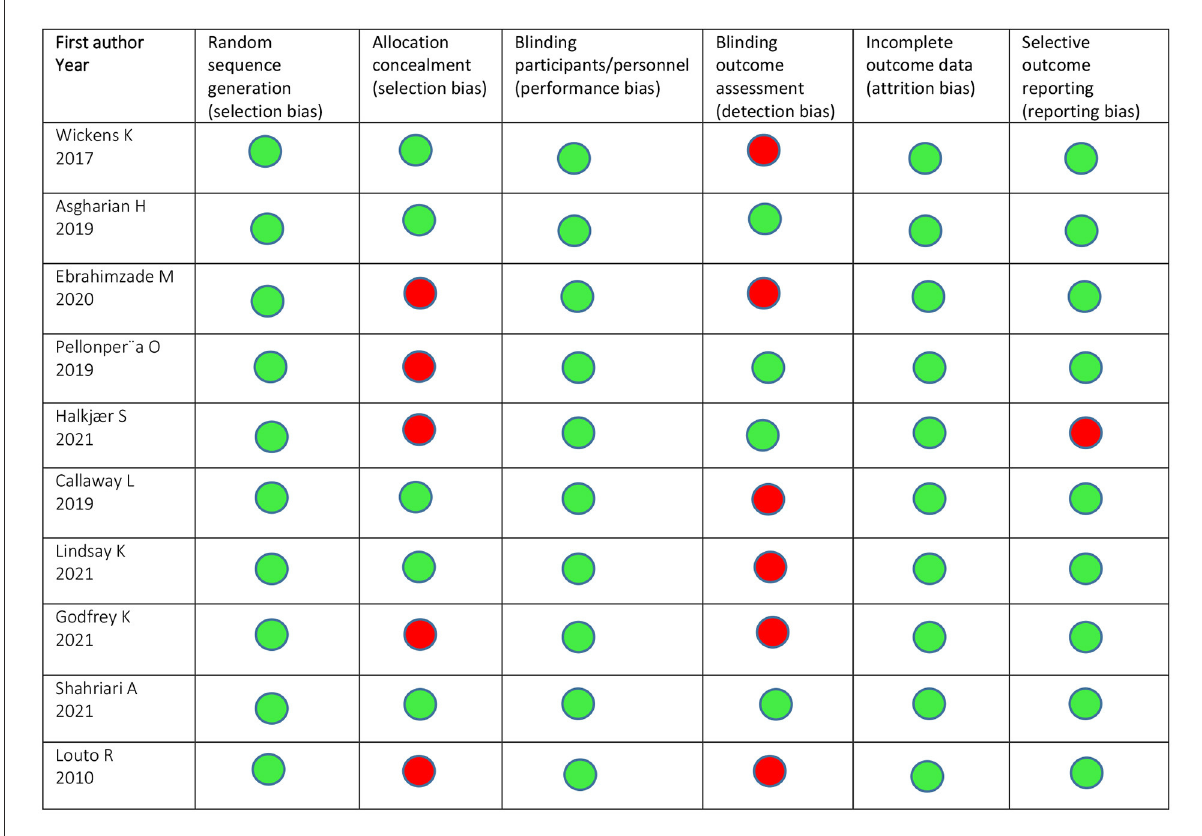
FIGURE3 Quality assessment of the included studies.